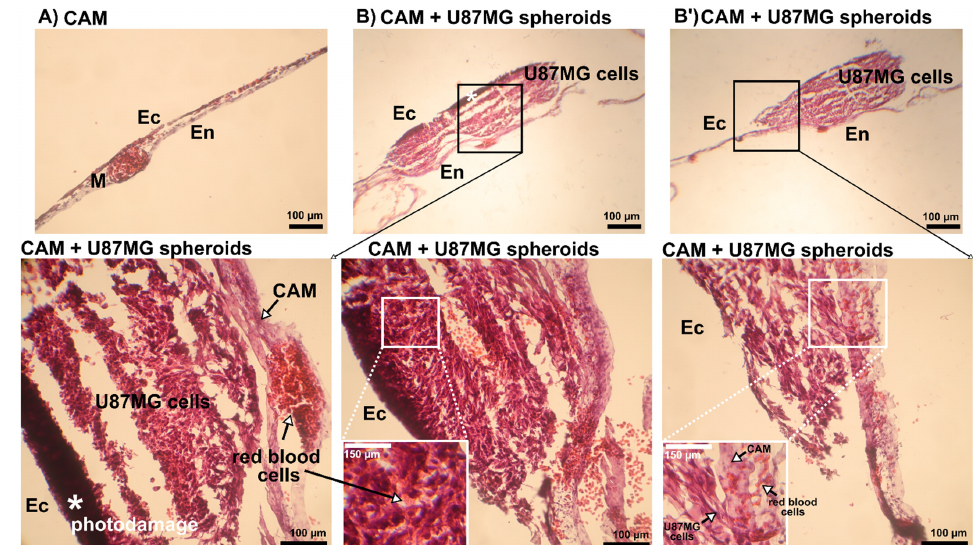
Figure 10. Representative H&E histology section of CAM with U87MG spheroids treated with 500 nM hypericin. ( A ) Region of CAM without spheroids (Ec-ectoderm, En-endoderm, M-mesoderm), and ( B , B’ ) two different views of CAM with U87MG cell spheroids. The second row of the panel shows zoomed regions of interest indicated by black rectangles in B and B’ rotated in position from En in left. Attachment of U87MG cells to CAM is visible. White asterisks * indicate photodamage to U87MG cells. The position of CAM, red blood cells, and U87MG cells in each section is indicated with a black arrow. The photodamage was caused by the light coming from the detection system during imaging. Scale bar represents 100 µm. Although macroscopic changes were not observed after PDT, PCR revealed some significant differences in the expression of genes related to the body’s immune response. In the case of IL-8 and TLR-7 , higher expression of the mentioned genes was observed after the application of hypericin, especially in the case of hypericin in the dark. After PDT the changes were not significant compared with the control group (Figure 11A). There were no significant changes in the expression of VEGF-A and Quek1 24 h after treatment (Figure 11A), but after the application of spheroids, we saw an increase compared with the tissue without spheroids (data not shown). When hypericin in the dark was considered as a reference (relative mRNA = 1), we also observed the effect of PDT on IFN- α gene expression compared with the application of hypericin in the dark (Figure 11B).